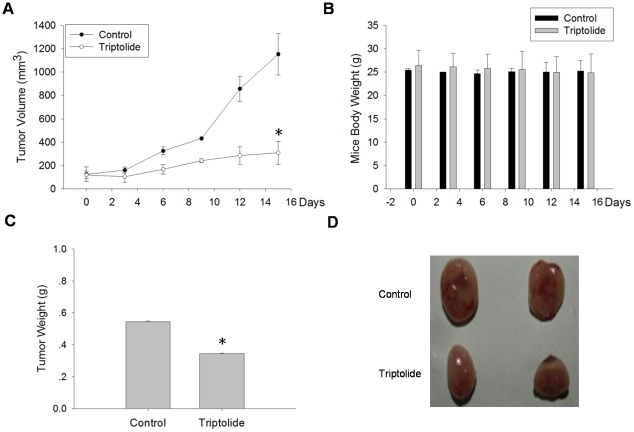
Triptolide suppressed PC-3 tumor progression in mouse xenograft model.PC-3 cells (2×106 per mouse) were injected into 5-week-old nude mice. When solid tumors grew to about 100 mm3, the mice were treated intraperitonneally with either a vehicle control or Triptolide at 0.4 mg/kg daily for 15 days. Tumor sizes and body weight were measured every three days. (A) Effect of Triptolide on xenograft tumor volume. (B) Effect of Triptolide on nude mice body weight. (C) Effect of Triptolide on xenograft tumor weight. (D) Image of xenograft tumor treated with or without Triptolide.* indicates P<0.05 (compared to control).